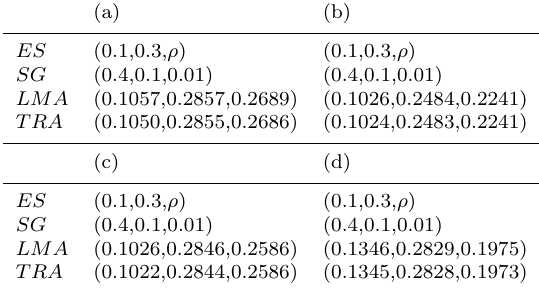
Table 2. The approximate location and the size of the coefficient with piecewise constant using LMA and TRA with exact solution ( ES ) and the starting guess ( SG ) along with 1% noise data for Example 2